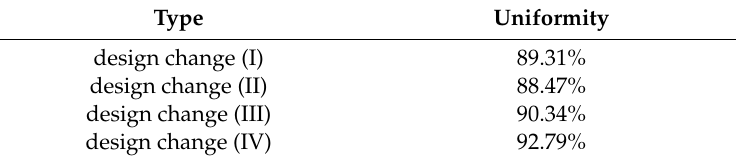
Figure 14. Simulation results of type (d) of each design change: ( a ) Results of design change (I), ( b ) Results of design change (II), ( c ) Results of design change (III), ( d ) Results of design change (IV). Table 7. Uniformity of type (d) of each design change simulation results.